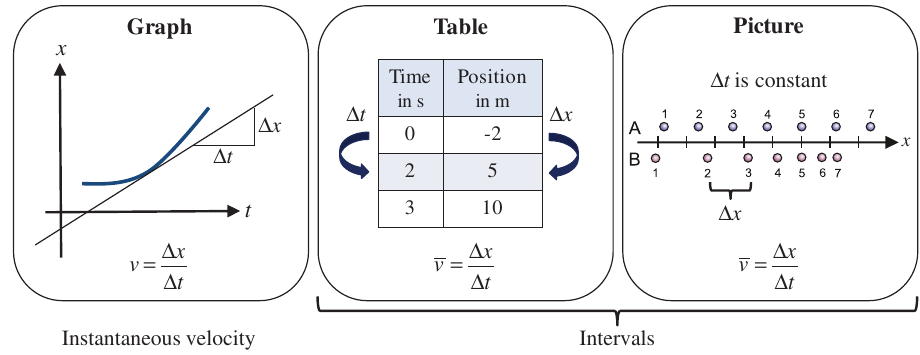
FIG. 1. Velocity as rate. In the case of a graph students must be able to determine the instantaneous velocity using the slope of the tangent. Using a table, students have to read out the difference in time and position in order to determine the velocity during the corresponding time interval. In a stroboscopic picture the time interval is constant and the velocity of the object is proportional to the distance between two subsequent